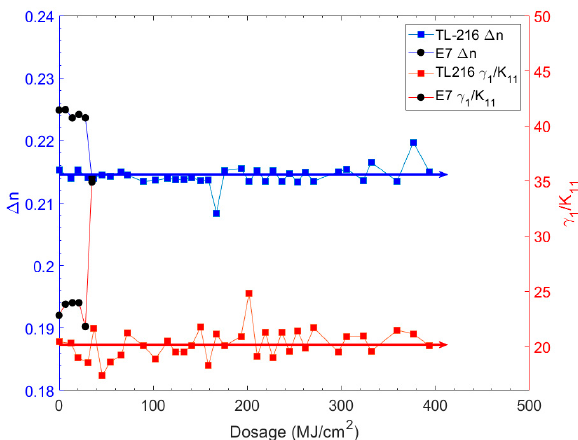
Figure 6. Measured photostability of E7 and Merck TL-216 with a blue laser at λ = 465 nm at 22 ◦ C. Probing laser λ = 633 nm.